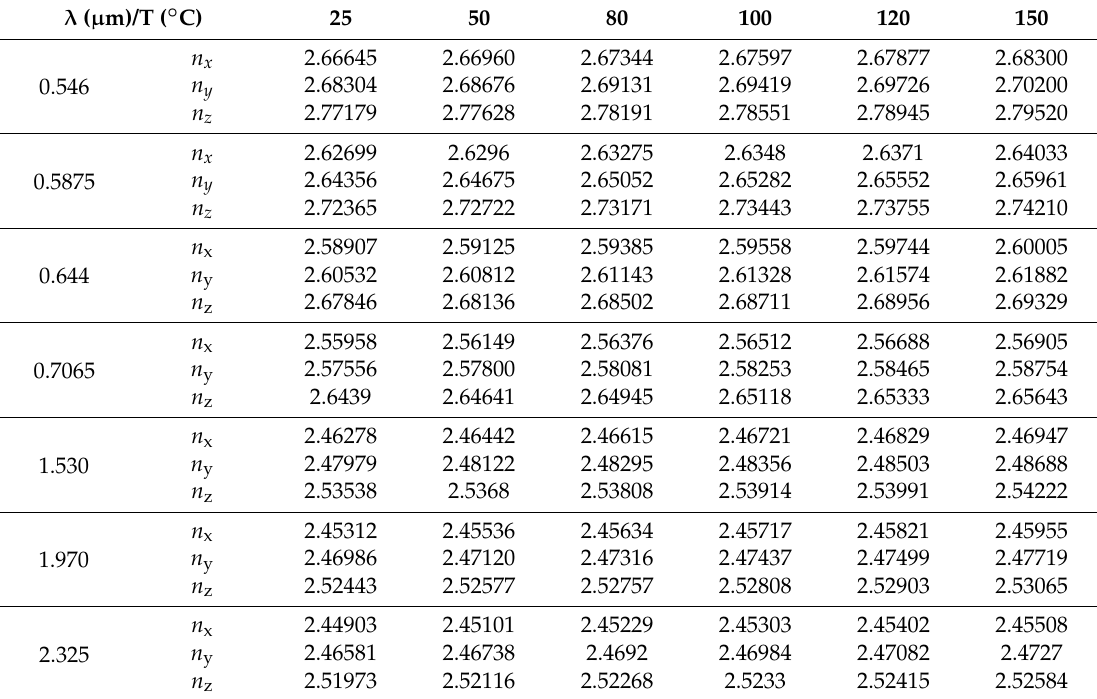
Table 1. Principal refractive indices of BaGa 4 Se 7